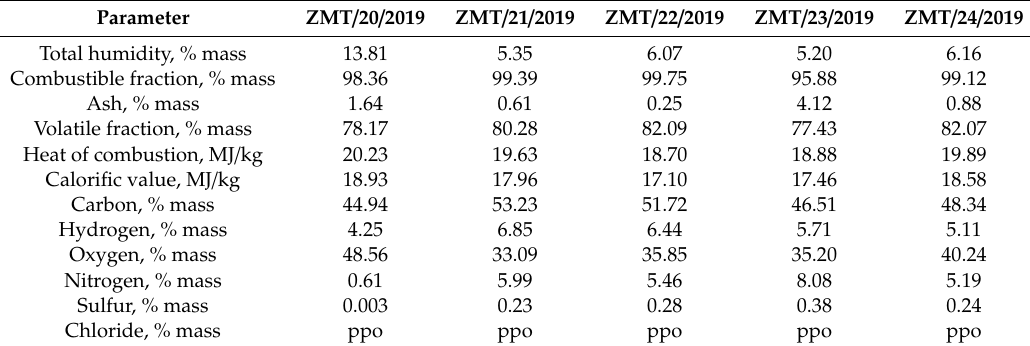
Table 2. Physicochemical properties of